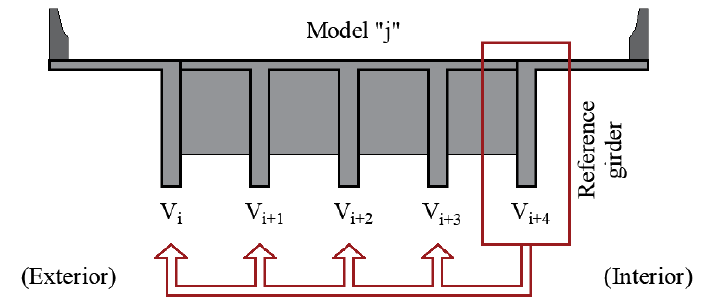
Figure 9. Methodology for Global